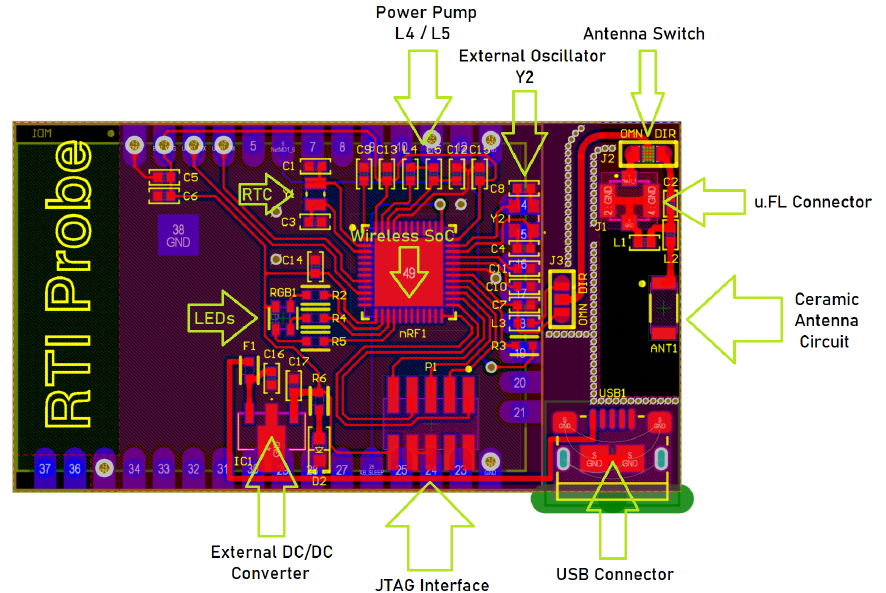
Figure 2. Mosaic of PCB electrical connections of the tomography radio probe.